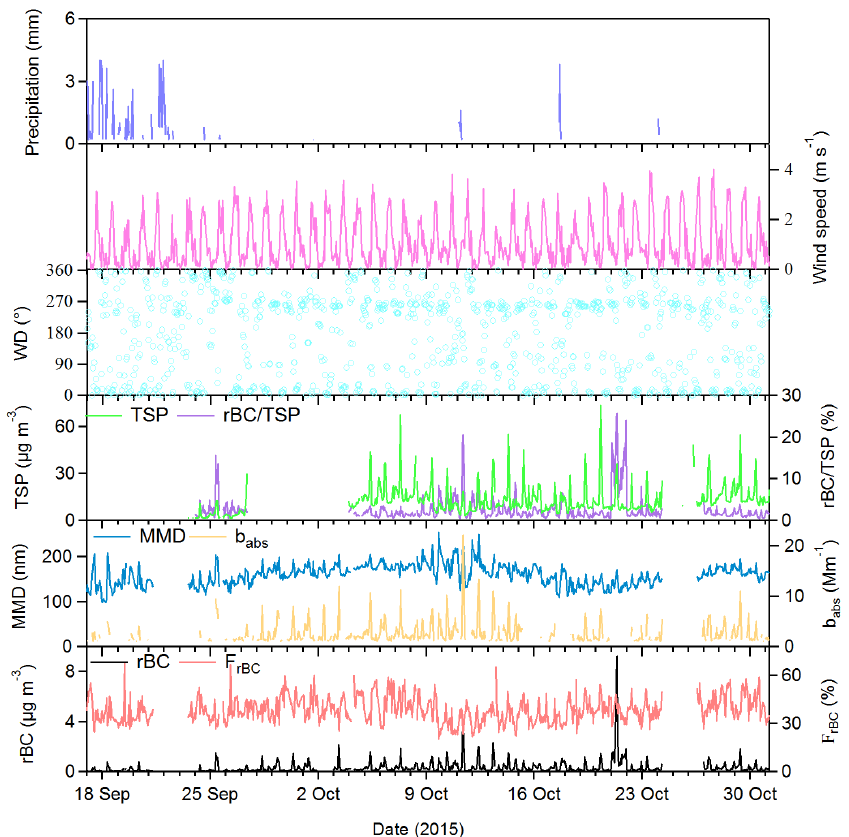
Figure 2. Time series plots of hourly averaged refractory black carbon (rBC) mass concentrations, number fraction of thickly coated rBC ( F rBC ), mass median diameter of rBC particles (MMD), total suspended particulate matter (TSP), rBC/TSP, light absorption coeffi- cient ( b abs ), wind speed, wind direction (WD), and